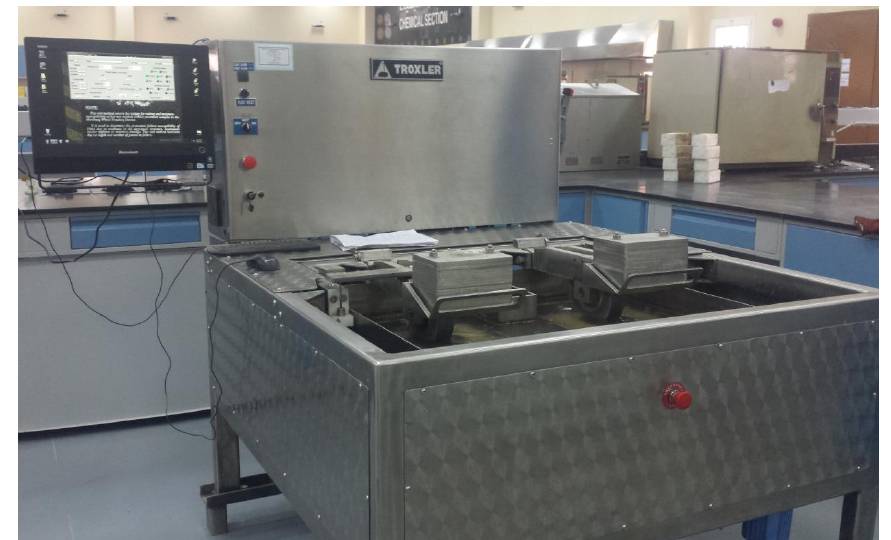
Figure 6. The Hamburg wheel tracker.